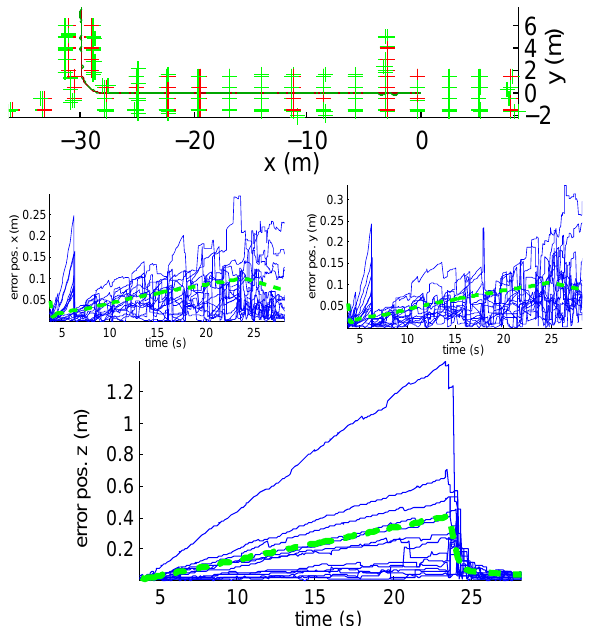
Figure 2. Evaluation of a simulated walk through a hallway. Top: Reference trajectory (dark red), estimated trajectory (dark green), landmark reference positions (red) and estimated landmark posi- tions (green) for one simulation run. Thereunder: Position error in the x-, y- and z-direction for 13 simulation runs (blue) with the square root of the Cram´er-Rao lower bound (dashed